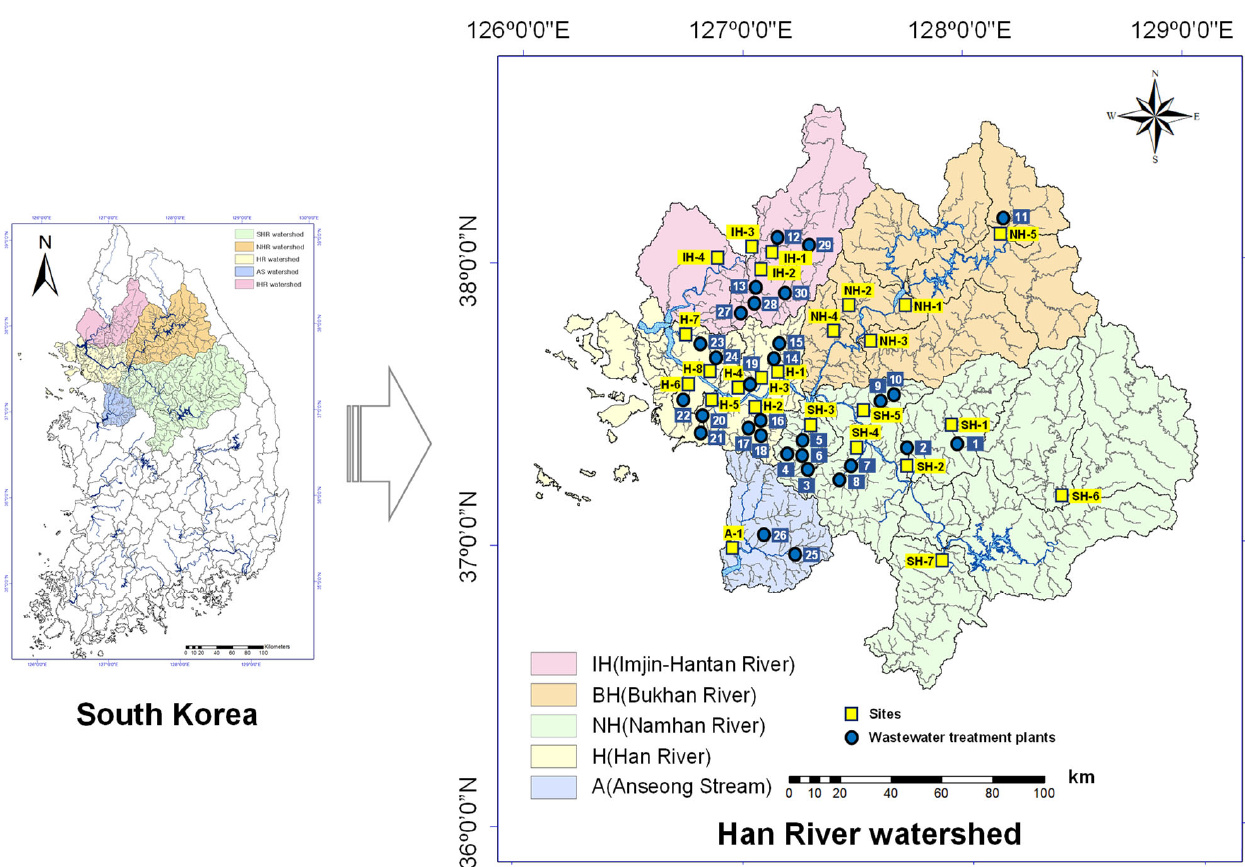
Figure 1. Description of study area and sampling sites in the Han River watershed.